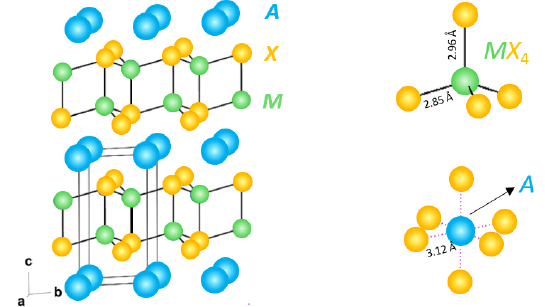
Figure 1. The crystal structure of AM 2 X 2 compounds with CaAl 2 Si 2 structure type, characterized by anionic (M 2 X 2 ) 2 − slabs sandwiched by monolayers of A 2 + cations. In the present study, we investigate alloying of A = Mg, Ca, Sr, and Ba in A Mg 2 Sb 2 . The bond distances labeled are that of MgMg 2 Sb 2